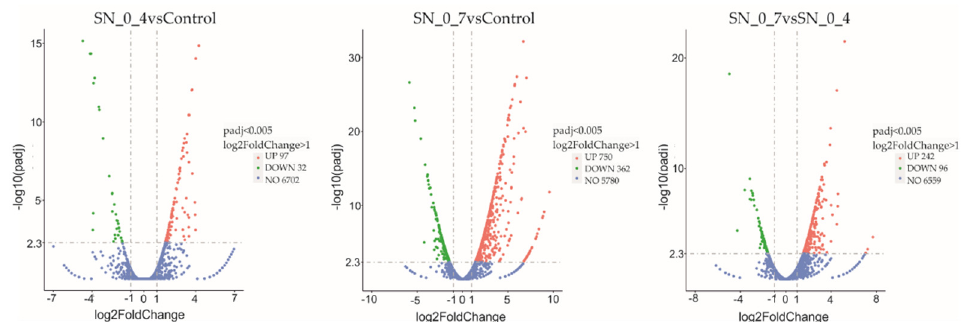
Figure 5. Volcano plot of distribution of differentially expressed genes. Horizontal axis: the fold change of genes in different samples. Vertical axis: statistically significant degree of changes in gene expression levels, the larger − log10(corrected p -value), the more significant the difference. The points represent genes, blue dots indicate no significant difference in genes, red dots indicate upregulated differential expression genes, green dots indicate downregulated differential expression genes. SN_0_4: cells incubated in supernatant derived from treatment with 0.4% peroxide; SN_0_7 cells incubated in supernatant derived from treatment with 0.7% peroxide; Control: cells incubated in diluted rich medium. Figures are provided by Novogene Bioinformatics Technology Co., Ltd.